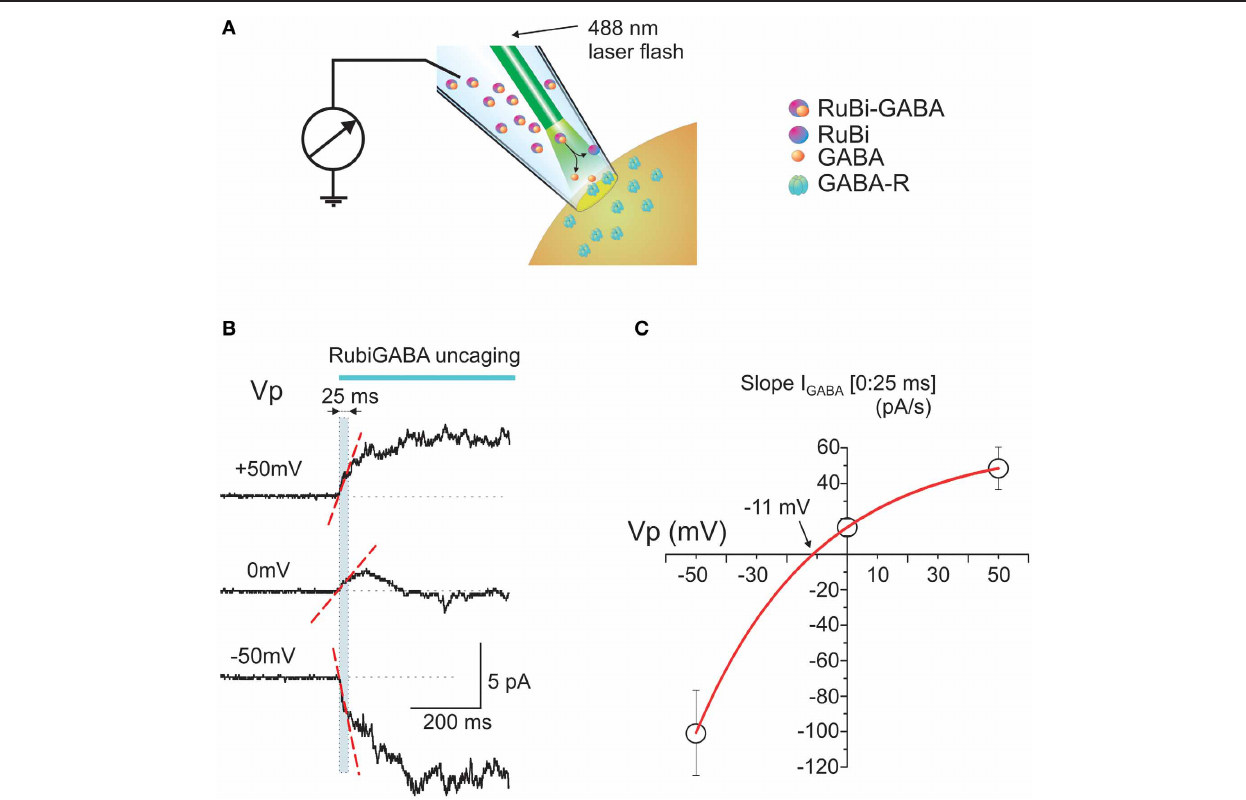
recordings from P2-5 cortical neurons at different pipette potentials. Note that the initial response slope (indicated by dashed red line in a [0:25ms] time window after the laser pulse onset outlined by cyan box) is positively directed (in cell-attached recordings the inward currents are upward) at the resting membrane potential ( Vp = 0mV), that it increases with patch hyperpolarization and changes its direction from depolarizing to hyperpolarizing during patch depolarization. (C) Plot of the dependence of the initial response slopes on the pipette potential. Data points show mean values ± S.E. Slope-voltage relationships are approximated with an exponential function which shows reversal near − 11mV that corresponds to DF GABA of +